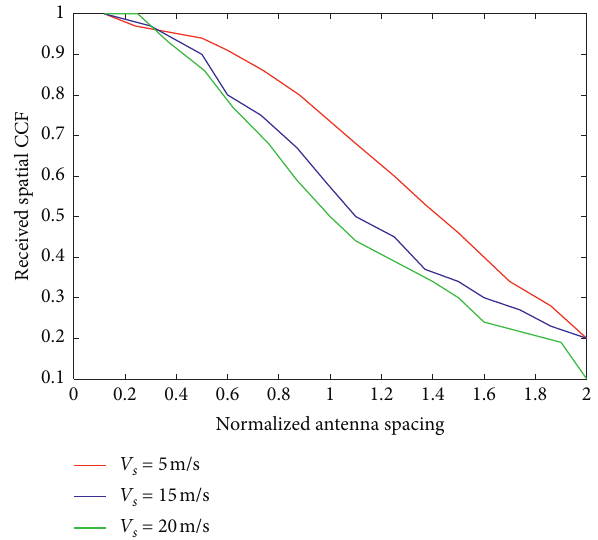
Figure 2: Received spatial CCF vs. normalized antenna spacing where V s refers to the velocity of scatterers